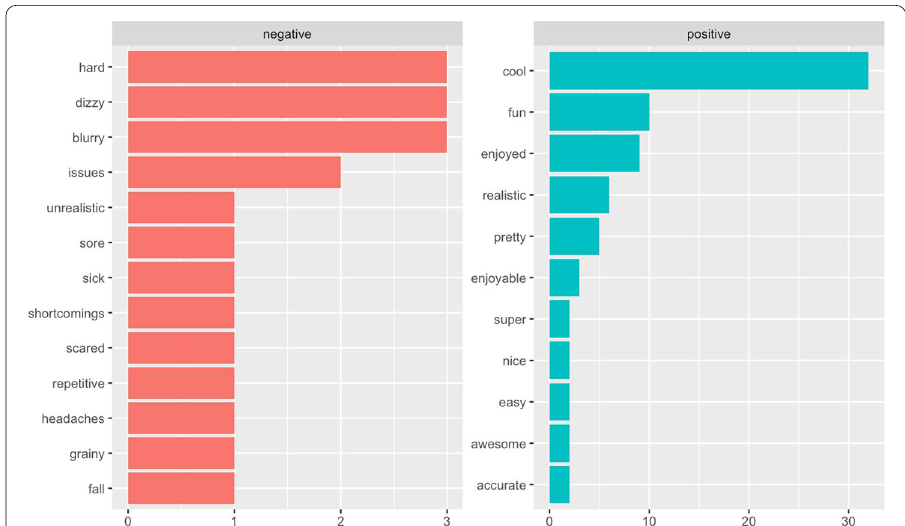
Fig. 2 Sentiment analysis results: Commonly mentioned negative vs. positive words